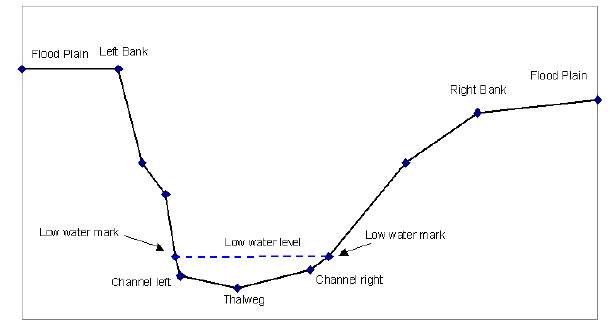
Fig. 3. Schematic diagram for a survey of a typical cross section.